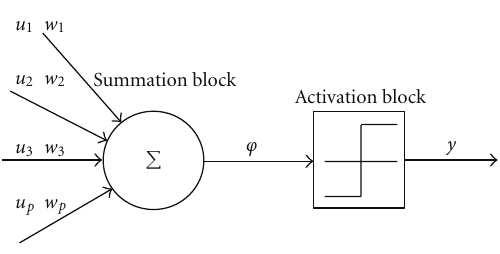
Figure 2: General model of an artificial